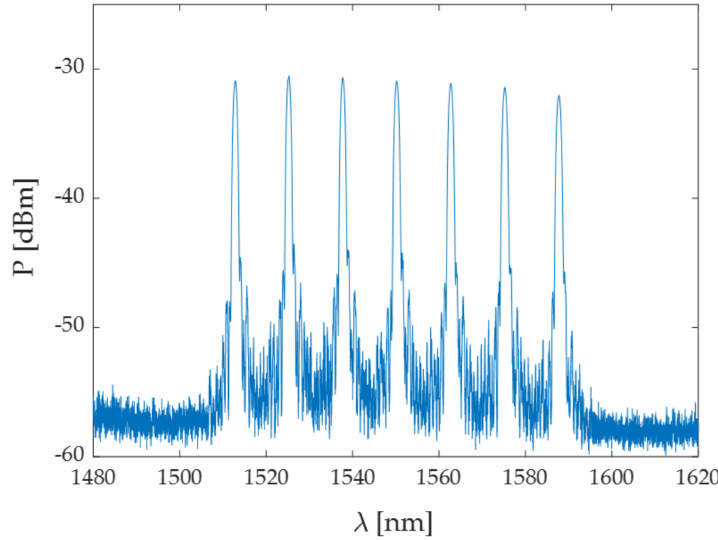
Figure 1. Optical spectrum shown by one of the two nominally identical arrays. The seven peaks corresponding to the λ B of each fiber Bragg grating (FBG) are clearly